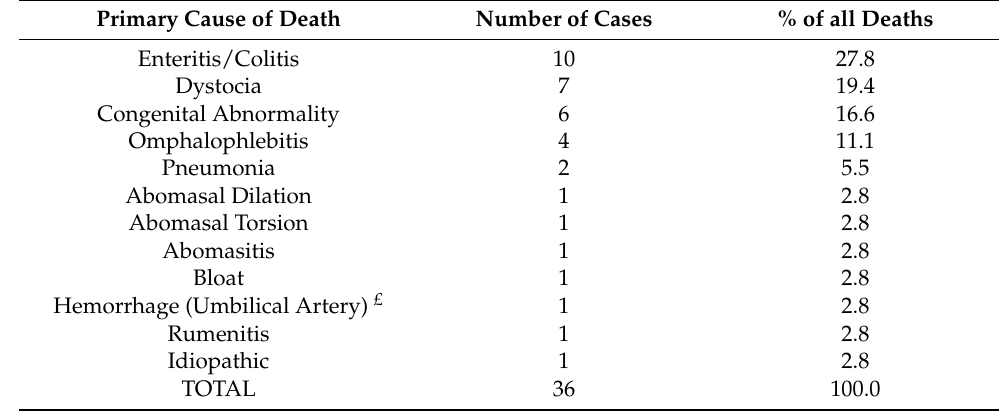
Table 3. Primary cause of death of 36 neonatal (1 day to 5 days old) calves diagnosed at